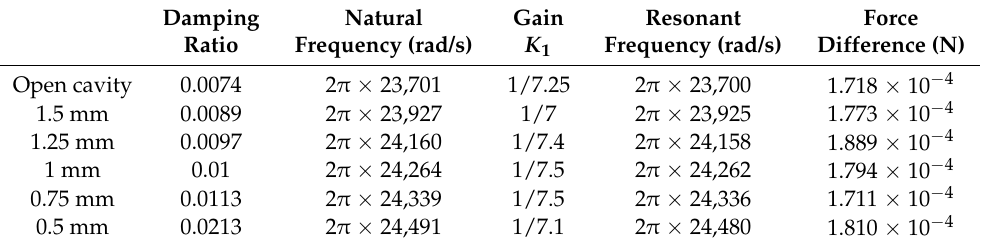
Table 1. The parameters of G ( s ) to fit the studied Helmholtz resonators with varied cavity volumes. Damping